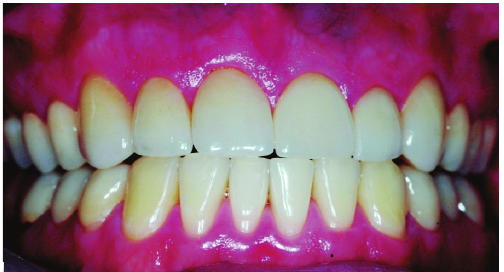
Figure 14: Healthy periodontal aspect after 4 years of restorations placement.